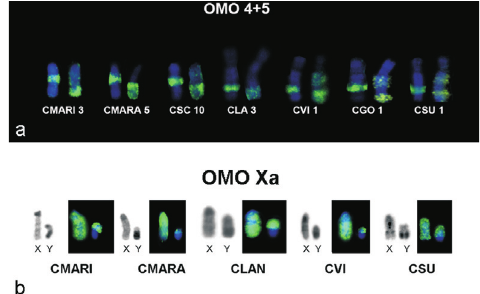
Figure 6 - OMO probe results. (a) Associations between OMO probes 4 and 5 detected in all Cerradomys species studied; (b) Homologies of sex chromosomes of Cerradomys . CBG-banding (on the left) and chromo- some painting using OMO Xa probe (on the